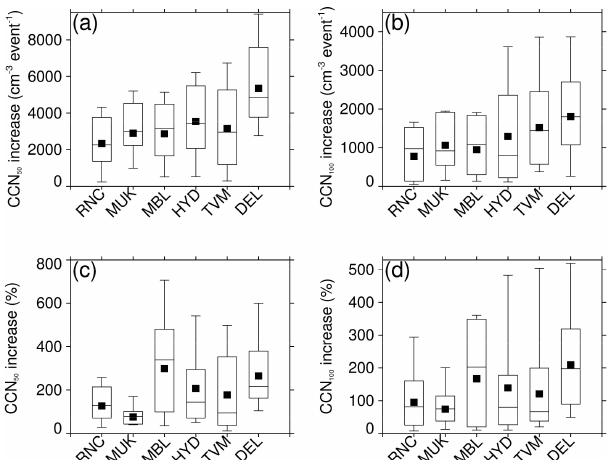
Figure 10. Box–whisker plot of absolute increase in CCN concen- trations for (a) 50 and (b) 100nm particles and percentage increase in CCN concentrations for (c) 50 and (d) 100nm at all the sites based on observed NPF and non-event days. The solid square indi- cates the mean, the horizontal line indicates the median, the top and bottom of the box indicate 25th and 75th percentile values, and the top and bottom whiskers indicate 10th and 90th percentile values. Note that measurements are from different time periods for each site (see Table